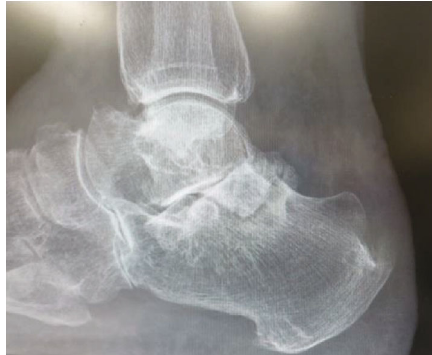
Figure 8: Lateral plain radiographic view of the right ankle showing no ossi fi ed loose bodies in the right posterior ankle extra-articular space.